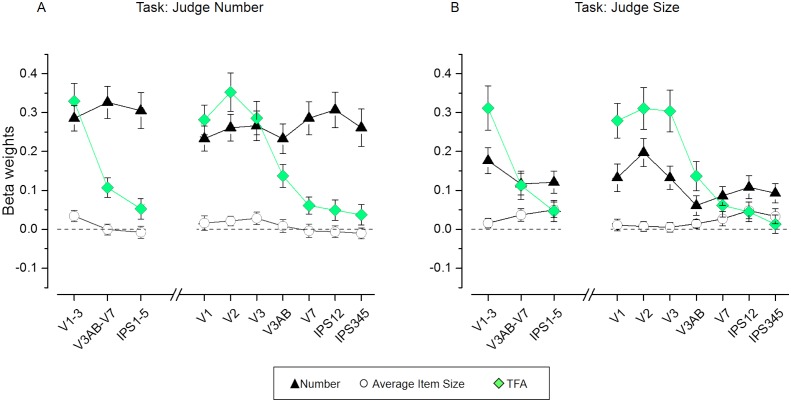
Results of the representational similarity analysis for a model including only number, average item size and total field area as predictors.Beta weights obtained from the RSA multiple regression for number (black triangles), average item size (circles), total field area (TFA, diamonds) for the number (A) and size (B) task. The triple interaction between ROI, task and dimension was significant both for the three large regions: F(2.86,54.43) = 4.73, p = 0.006 as well as for the individual regions: F(4.52,85.95) = 3.34, p = 0.01. When quantifying the changes in beta weights across ROIs and tasks for each dimension separately, the interaction between these factors was close to significance for number (for the three large regions: F(1.48,28.19) = 3.49, p = 0.0569; for the individual regions: F(2.25,42.69) = 2.92, p = 0.0589). The interaction between ROI and task was significant for average item size (for the three large regions: F(1.74,33.12) = 5.32, p = 0.01; for the individual regions: F(2.70,51.22) = 3.07, p = 0.04), however the near zero beta values estimated for this dimension make this result difficult to interpret, and not significant for total field area (for the three large regions: F(1.51,28.69) = 0.22, p = 0.74; for the individual regions: F(2.87,54.47) = 0.67, p = 0.56). Data points show mean beta weights across subjects (n = 20) ± standard error of the mean (SEM). P-values indicating the significance of the beta coefficients for each dimension and ROI are reported in Supplementary file 5.